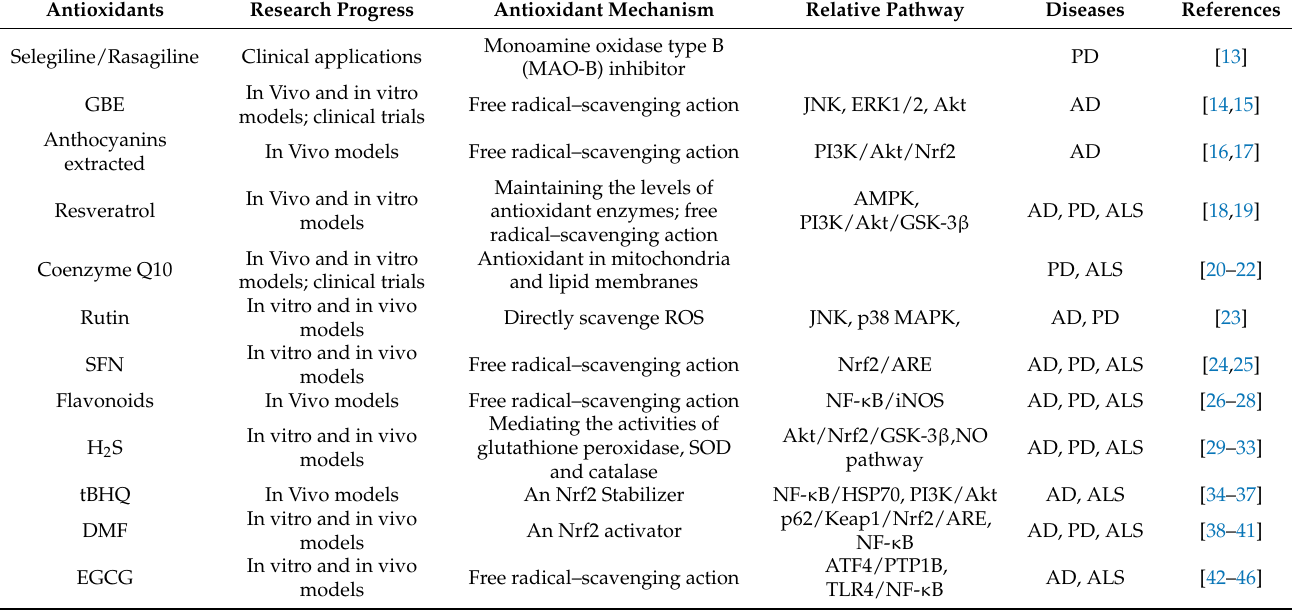
Table 1. Advances in research on antioxidants in neurodegenerative